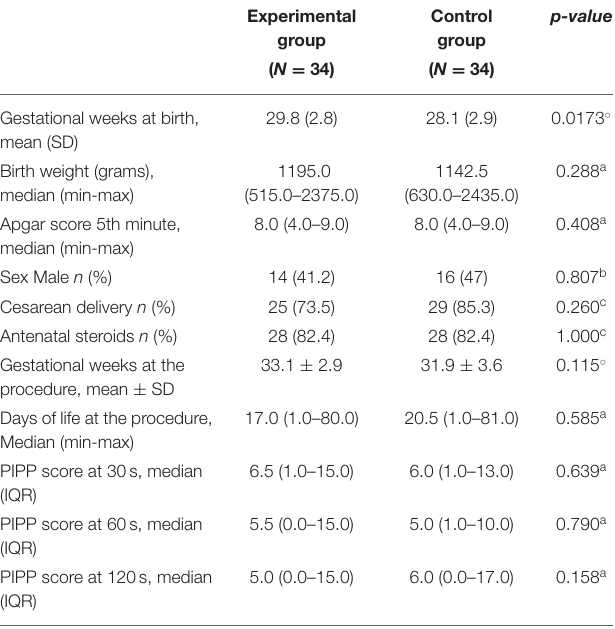
TABLE 1 | Patient characteristic and PIPP scores at 30s, 60s,120s in both groups of treatment.